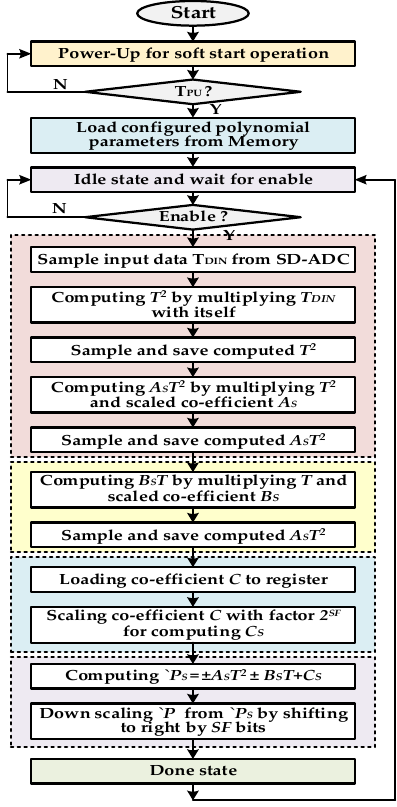
Figure 6. Polynomial finite state machine (FSM) controller flow